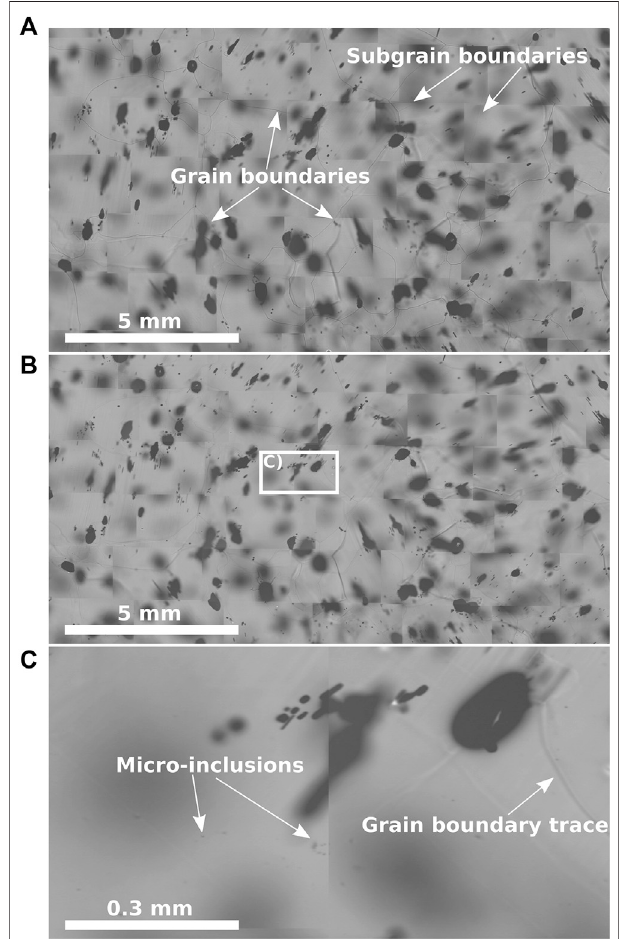
Figure 4 | Different steps of microstructure mapping of a sample from a depth of 757.4 m of the EGRIP ice core, Greenland (Stoll and Weikusat, 2020). (A) Microstructure map of the surface, grain- and subgrain boundaries are indicated. (B) The same section as in (A) , but with a focus depth of 500 μ m to locate impurities inside the ice without the risk of surface contamination. (C) Detailed view of the indicated area in (B) , arrows indicate micro-inclusions. The fi gure concept is based on similar fi gures, such as Figures2,3, and 5from Kipfstuhlet al.,(2006),Figures 1 and 4from Weikusat et al. (2009), and Figure 1 from Eichler et al. (2017).